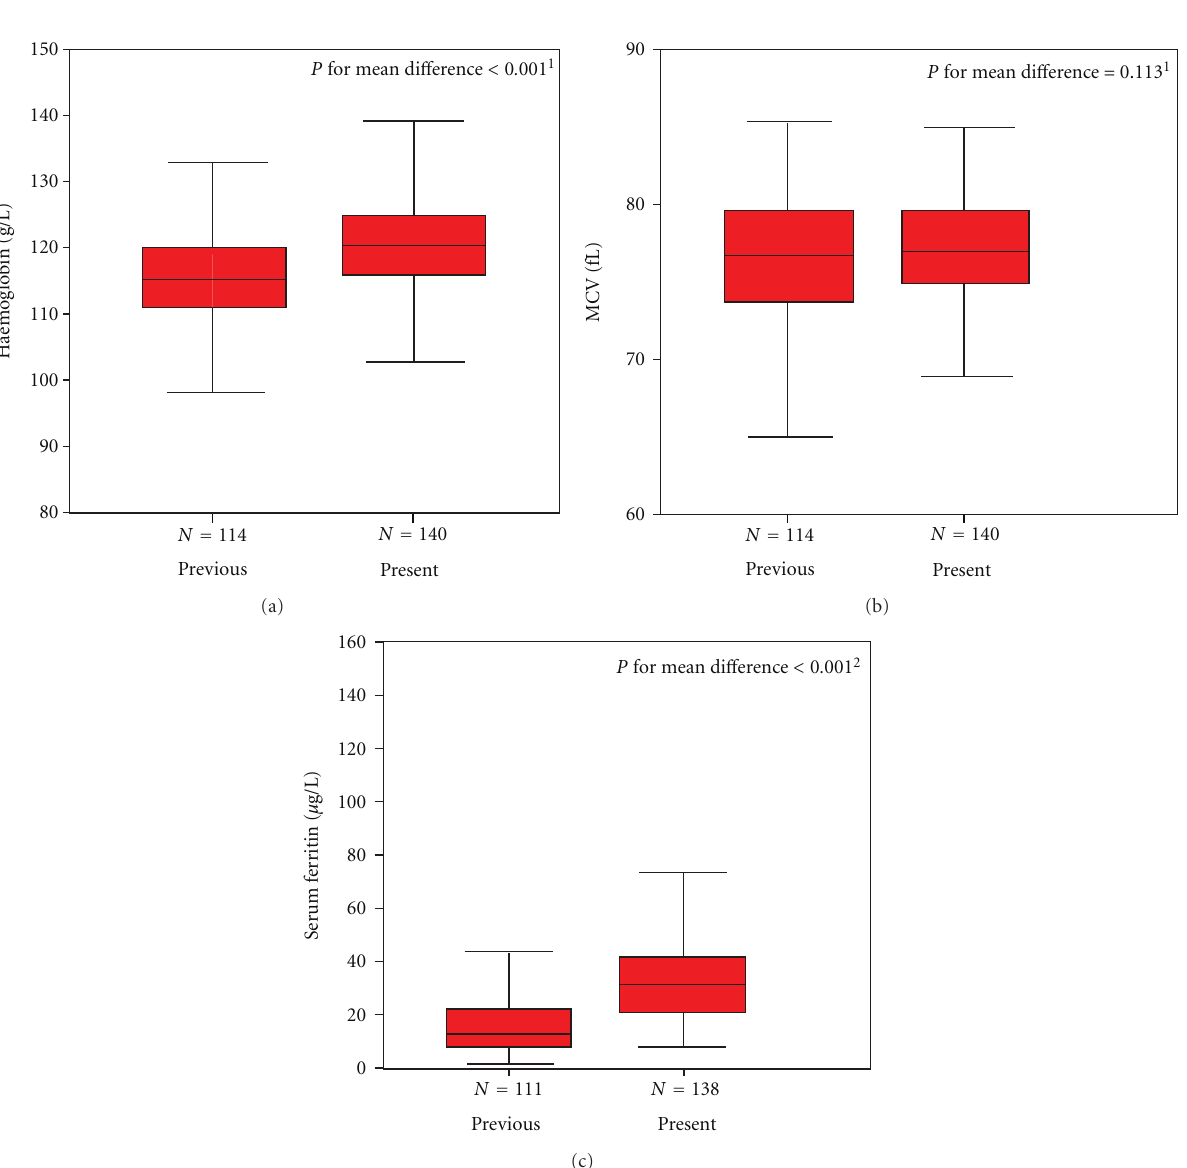
Figure 1: Box plots of iron status indices in 12-month olds, from previous (1995–1997) and present (2005–2007) studies. The box plots show the median, quartiles, maximum, and minimum values. Independent t -test was used for hemoglobin ( P = . 001), and MCV ( P = . 113), data were normally distributed and Mann-Whitney test for serum ferritin ( P = . 001) data were not normally